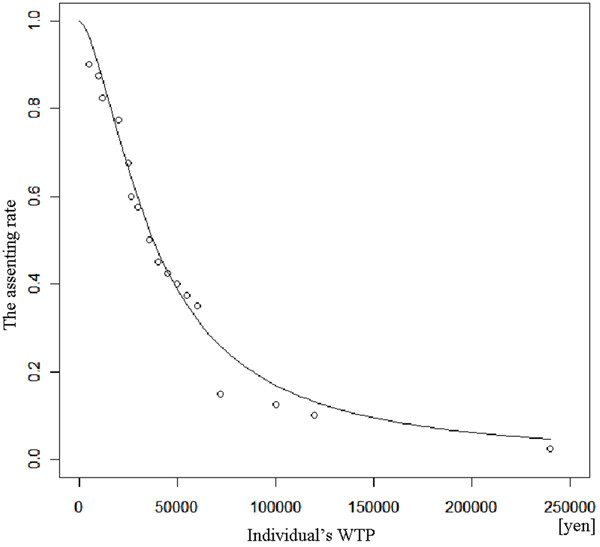
Plot of individual WTP and estimated demand curve. The median WTP was estimated to 39,484 yen ($438.71), with a 95% confidence interval of 27,806-55,437 yen ($308.95-615.96). The Nagelkerke's coefficient of determination was 0.972.